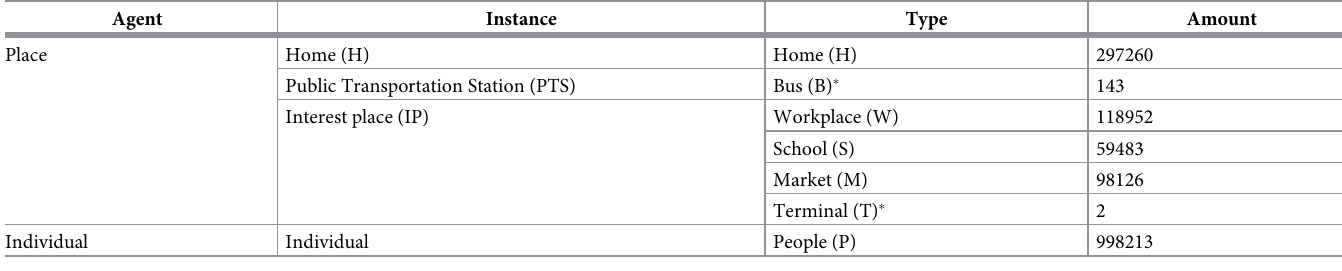
Fig 2 shows an example of 1000 virtual places in the Euclidean map of Bogota´ [35]; also, the figure shows the associated complex network of connected places (nodes are places and edges are routed between places), the graph was drawn with Gephi [36].